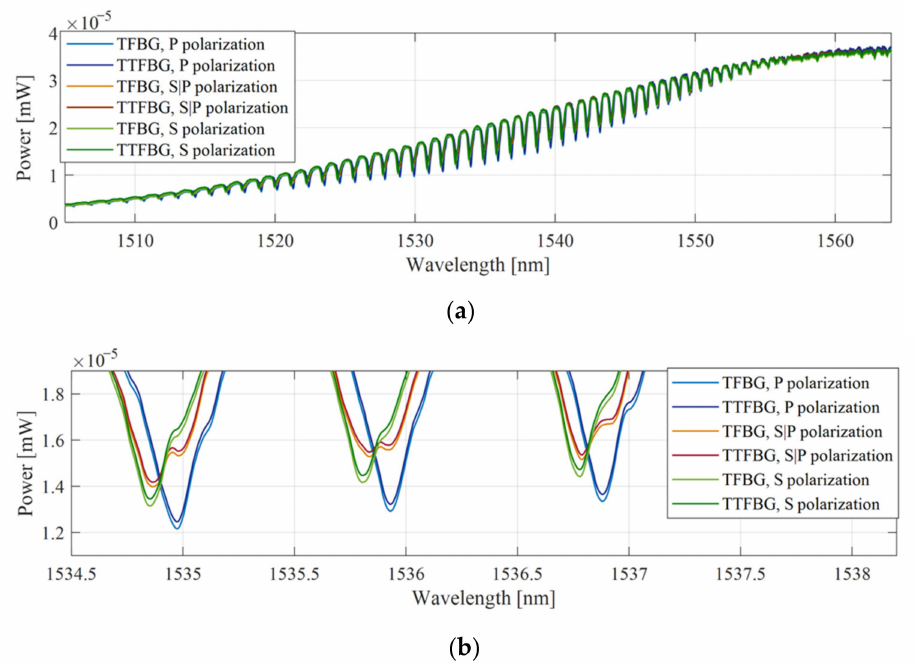
Figure 9. Comparison of the spectral characteristics of two structures TTFBG with the twist angle equal to 90 ◦ and TFBG twisted for the time of measurements by the angle equal to 90 ◦ : ( a ) the whole spectral range, ( b ) selected spectral range corresponding to three selected cladding